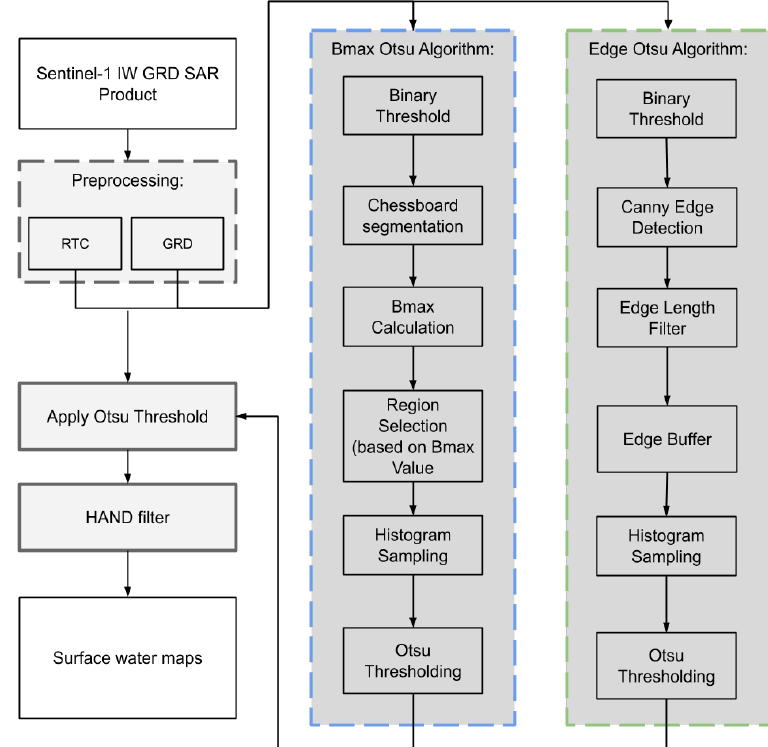
Figure 2. The surface water mapping effort utilized two processing workflows differentiated by the algorithms employed Bmax Otsu (outlined in blue) and Edge Otsu (outlined in green). Each workflow employed the same two pre-processing data streams “RTC” and “GRD” and same post processing